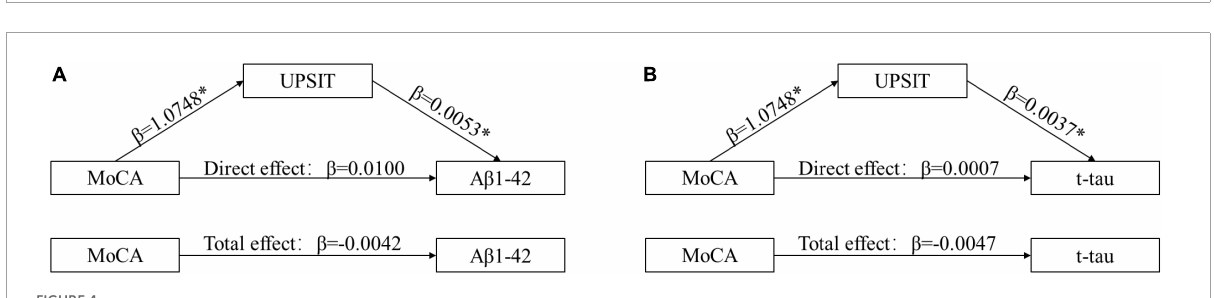
FIGURE4 Olfactory dysfunctions mediate the effects of Montreal Cognitive Assessment (MoCA) on cerebrospinal fluid (CSF) biomarkers. Causal-step approach showed that (1) MoCA was significantly associated with olfaction and rates of CSF biomarkers change; (2) olfaction was associated with CSF biomarkers; (3) when controlling for olfaction, the associations between MoCA and rates of CSF biomarkers were still significant ( P < 0.05). As such, all conditions for mediation were met. For A β 1 − 42 (A) and t-tau (B) , the Sobel test for mediation estimated that the percentages of total effect mediated by olfaction were 35% ( z = 2.1965; P = 0.024) and 37% ( z = 0.7674; P = 0.026), respectively. ∗ P < 0.05. MoCA, Montreal Cognitive Assessment; UPSIT, University of Pennsylvania Smell Identification Test; CSF, cerebrospinal fluid; A β 1 − 42 , amyloid- β 1 − 42 ; t-tau, total